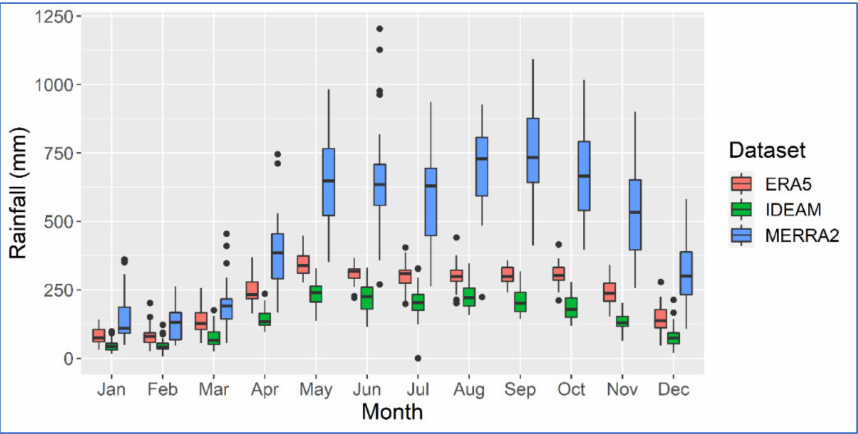
Figure 3. Average monthly rainfall in the whole Sin ú River basin based on the three datasets for 1985–2019. In this boxplot, the extremes of the box are the first (Q1) and third (Q3) quartiles; the bar indicates the median; the whiskers correspond to Q1—1.5 IQR (interquartile range) and Q3 + 1.5 IQR. The points are potential